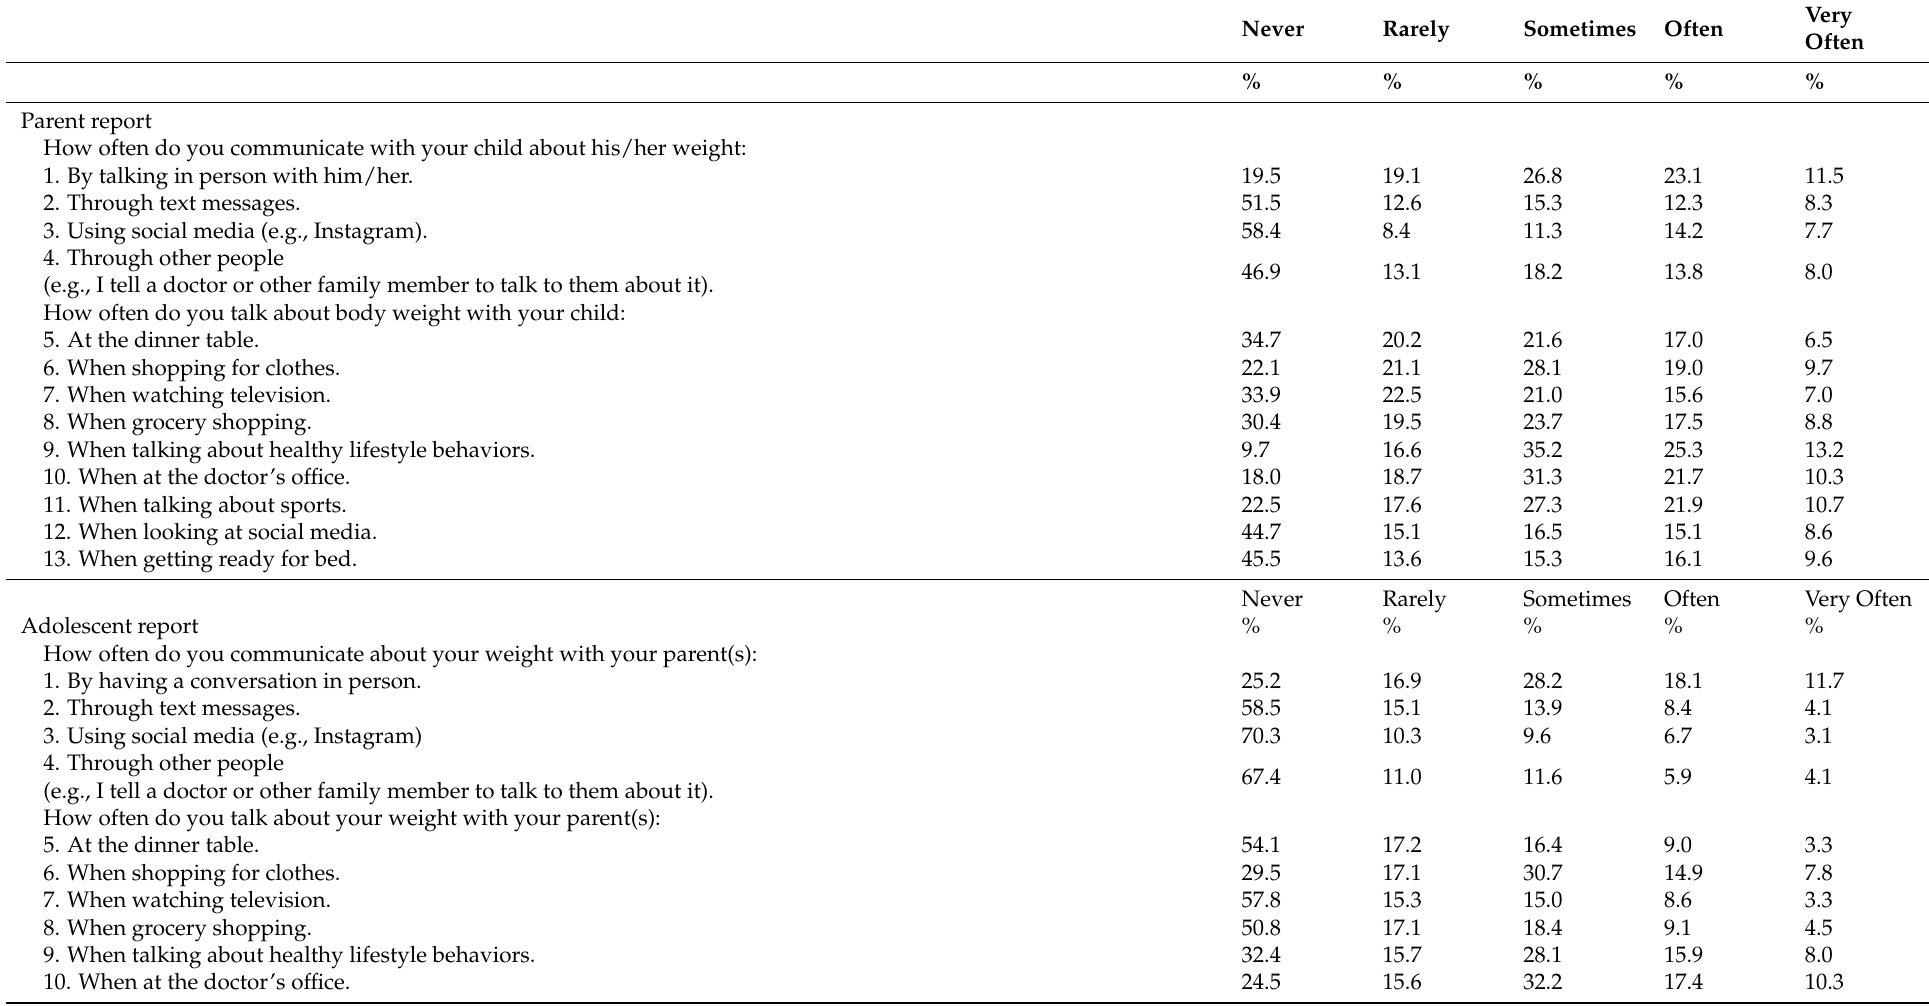
Table 8. Parent and adolescent reports of contextual aspects of parental weight